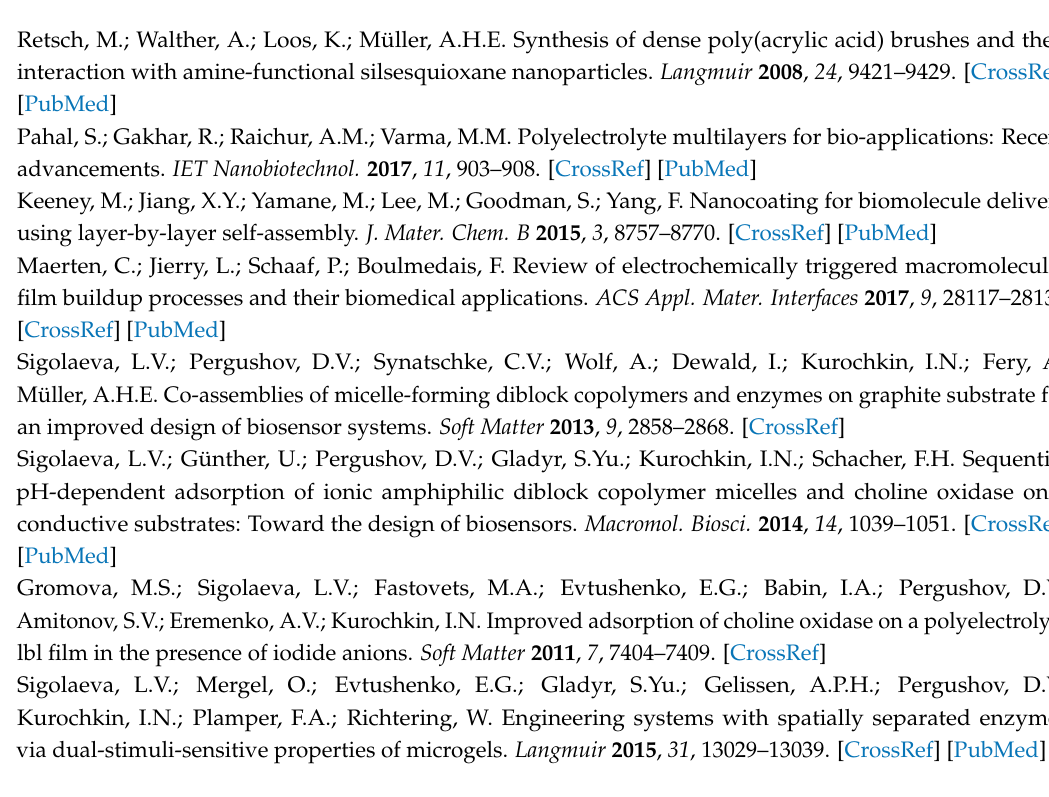
Figure S1: The temperature dependence of the hydrodynamic radius of P(NIPAM- co -DMAPMA) microgel particles; Figure S2: The pH-dependences of the hydrodynamic radius and ζ -potential of P(NIPAM- co -DMAPMA) microgel particles; Figure S3: The pH-dependence of the surface ζ -potential for the PVC film as measured by EKA; Figure S4: The relative biosensor responses of the SPE/MnO 2 /P(NIPAM- co -APMA)/ChO construct (open circles) and the SPE/MnO 2 /P(NIPAM- co -APMA)/ChO construct cross-linked with GA (solid circles) to consecutive additions of a choline solution with the concentration of 5 × 10 − 5